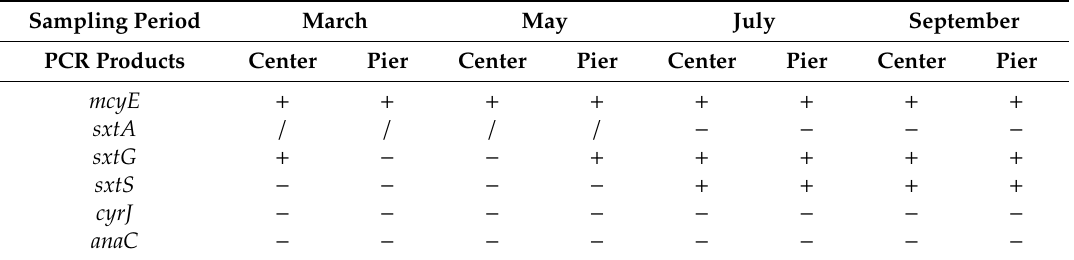
Table 4. The prevalence of mcyE, sxtA, sxtG, sxtS, cyrJ and anaC PCR products in Lake Ludoš.